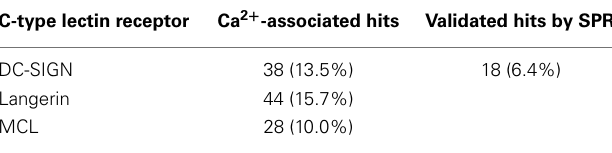
Table 3 | Hit rates for three C-type lectin receptors from 19 F NMR screening against a library of 281 compounds and hits confirmed by SPR for DC-SIGN